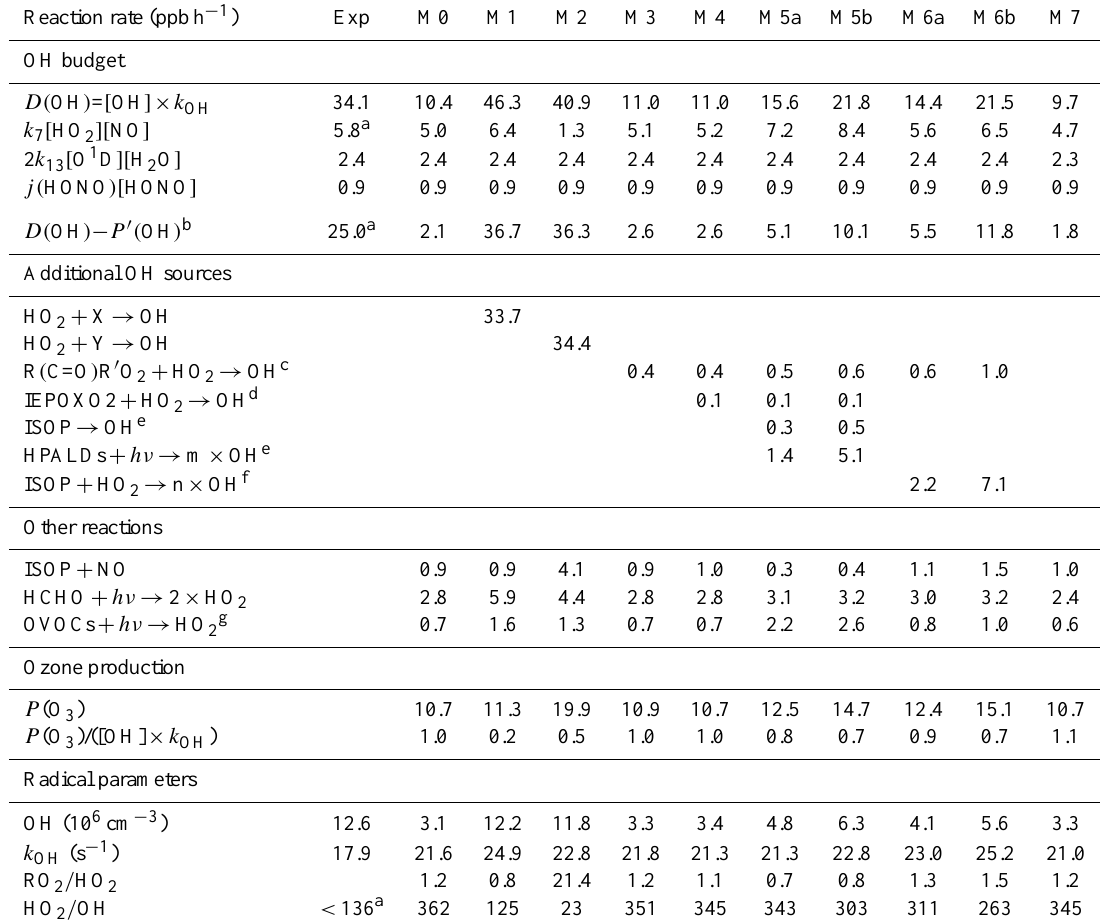
Table 7. Reaction rates (ppbh − 1 ) and radical parameters averaged over the afternoon hours (12:00–16:00CNST) from observation (Exp) and different model scenarios